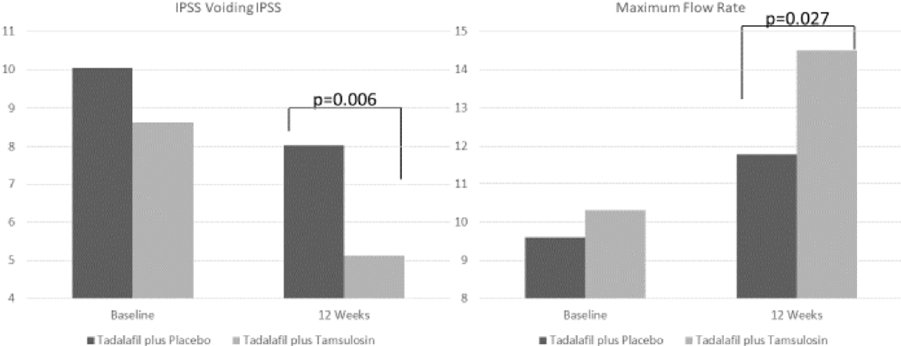
Figure 2. Change from baseline to 12 weeks for tadalafil and tadalafil plus tamsulosin (combination) groups. Graphical representation of the significant differences between the two groups. IPSS = International Prostate Symptom Score.